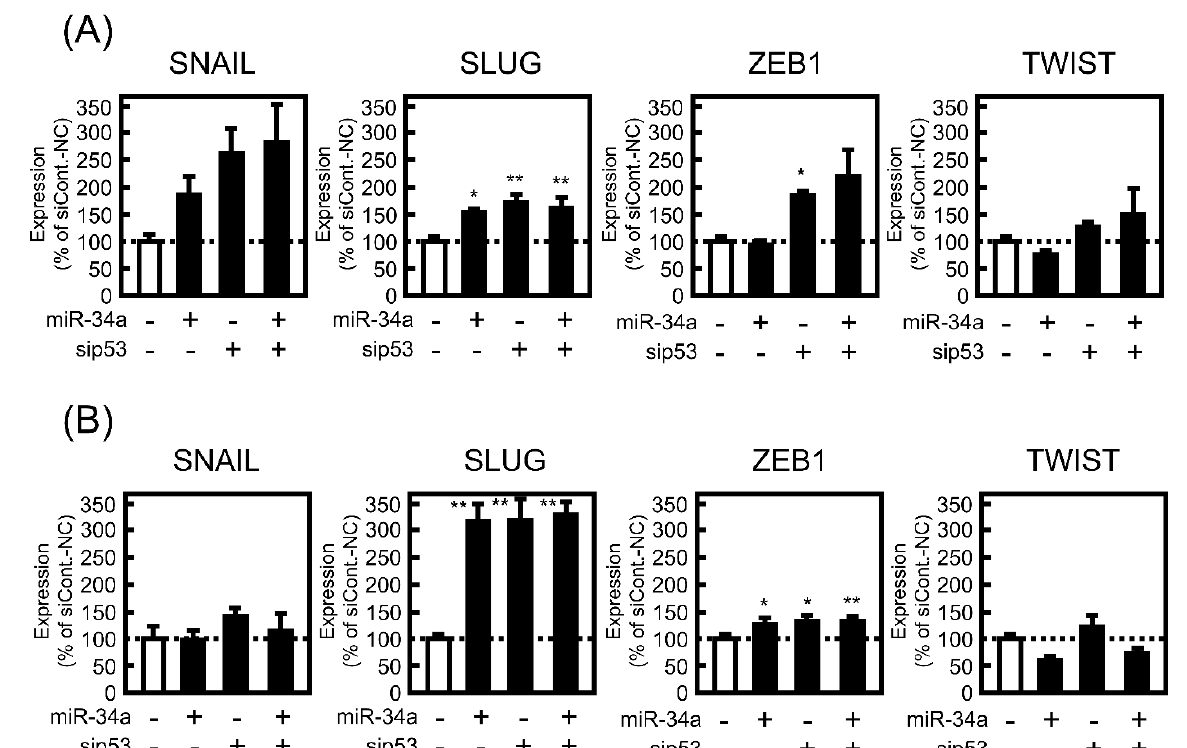
Figure 4. Contribution of p53 to EMT-related phenotypes in A549 cells under miR-34a overexpression. The cells were transfected with NC (20 pmol/well) or miR-34a mimic (20 pmol/well) under the control siRNA (siCont.; 10 pmol/well) or sip53 (10 pmol/well) for 24 h. After 72 h, ( A ) miR-34a and mRNA expression levels of ( B ) α-SMA, vimentin, N-cadherin, and ( D ) CDKN1A were measured by real-time PCR. ( C ) The protein levels of α-SMA and p53 were analyzed by Western blotting. ( E ) The migration ability was confirmed by scratch-wound assay as described in the Materials and methods sec- tion. Each value represents the mean ± S.E.M. (n = 3). * p < 0.05, ** p < 0.01, significantly different from NC under siCont. condition, †† p < 0.01, significantly different from miR-34a mimic under siCont. condition.